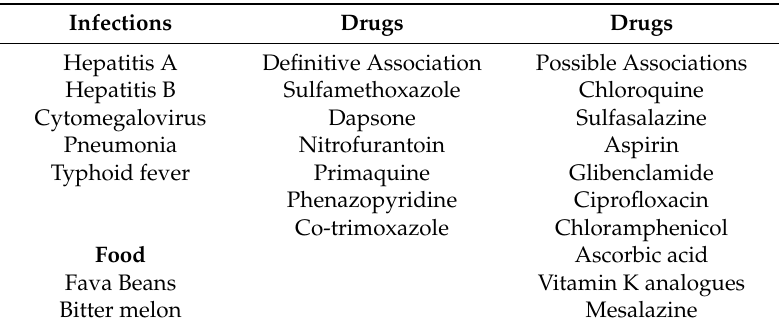
Table 1. Common triggers for hemolysis in G6PD deficiency